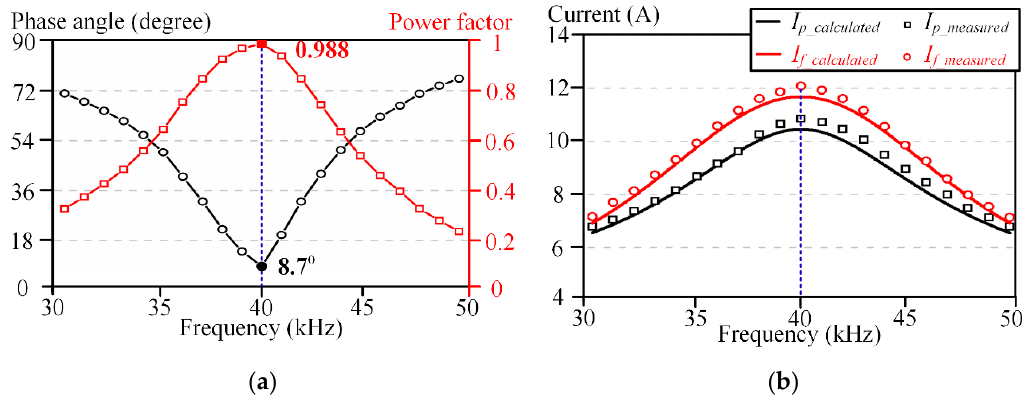
Figure 13. Frequency response. ( a ) Phase angle and power factor. ( b ) RMS value of currents.